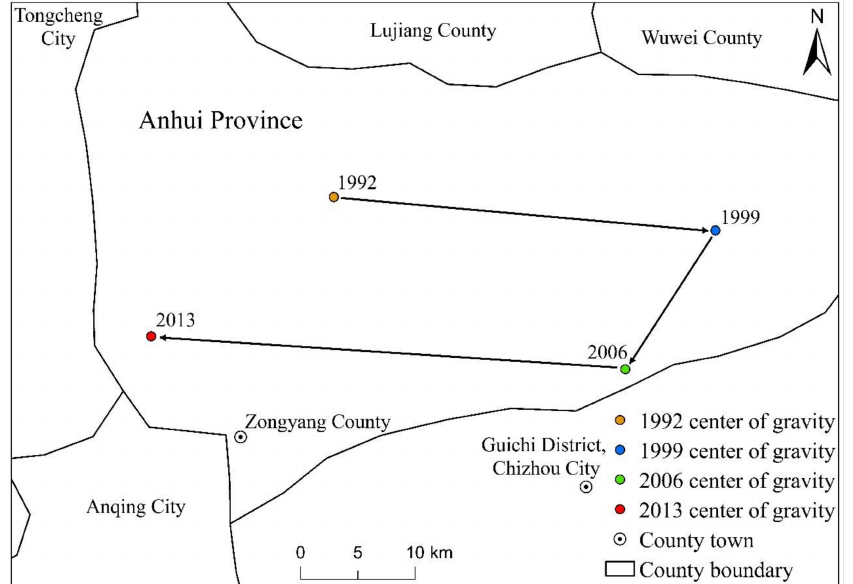
Figure 13. The distribution of the average center of gravity movement trajectory of the three major urban agglomerations of YREB from 1992 to 2013.